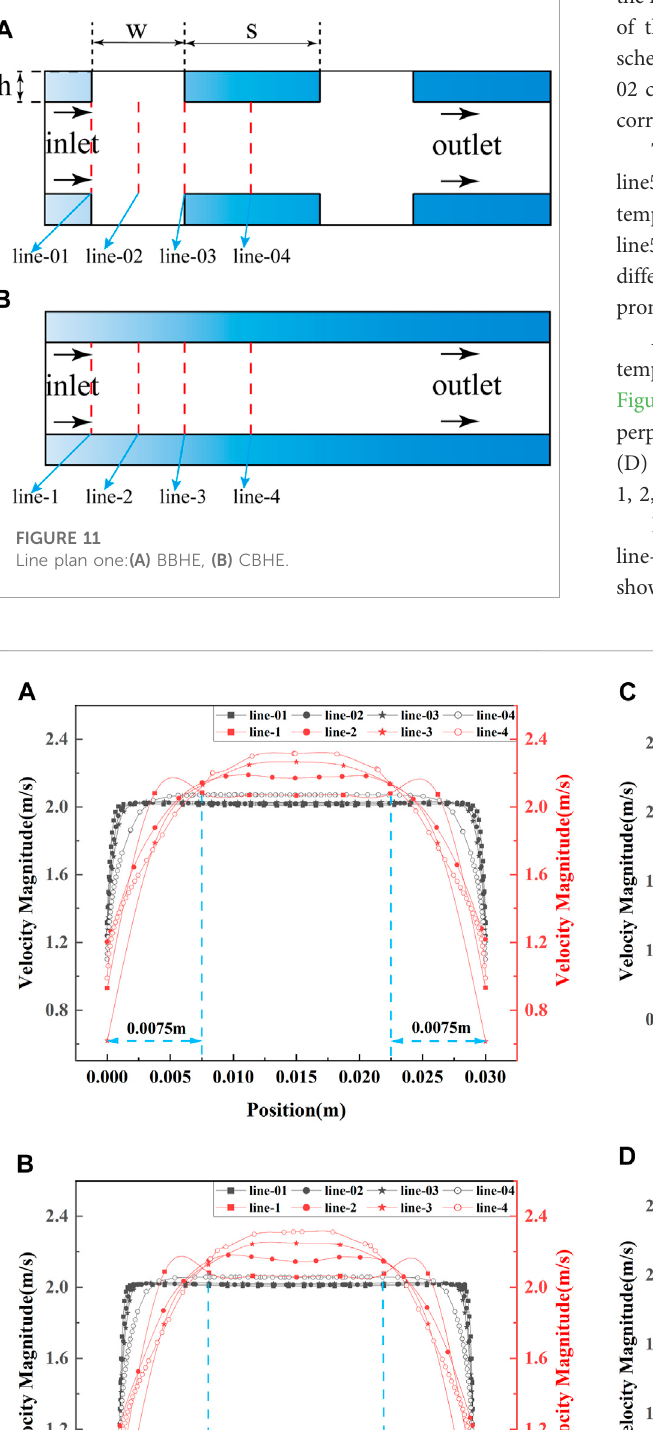
Frontiers in Energy